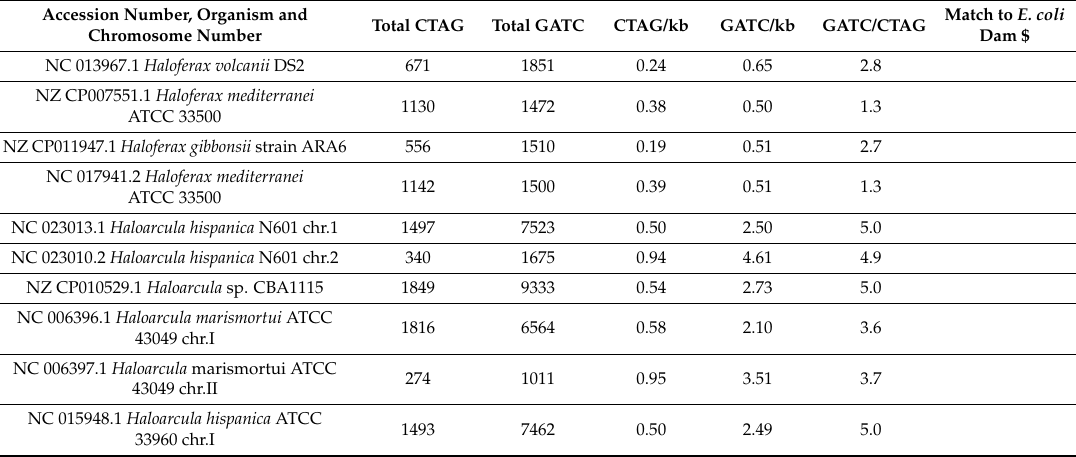
Figure 1. Amino acid alignment of HVO_0794 homologs. The multiple sequence alignment includes HVO_0794 ( Haloferax volcanii DS2; GenBank ADE02643), M.HsaR1I ( Halobacterium salinarum R1; GenBank CAP14114), M.MthZI ( Methanothermobacter thermautotrophicus ; GenBank CAA48447), M.MjaI ( Methanocaldococcus jannaschii DSM 2661; GenBank AAB98988) and M.BfaI ( Bacteroides fragilis ; GenBank ADQ20483). Identified N 4-cytosine methyltransferase motifs I-X [9] are highlighted in blue (representing S -adenosyl methionine (AdoMet) binding motifs), purple (representing DNA binding motif), and yellow (representing catalytic motifs). Red boxes are used to identify the signature DPPY and FGG motifs. The SCOP superfamily domain S -adenosyl- L -methionine-dependent methyltransferase domain SSF53335 is highlighted in green throughout the alignment. Clustal X2 shading and marking of amino acids is included in the alignment. Table 4. CTAG and GATC motif frequencies in completely sequenced halobacterial chromosomes. Data for Escherichia coli K12 are given for